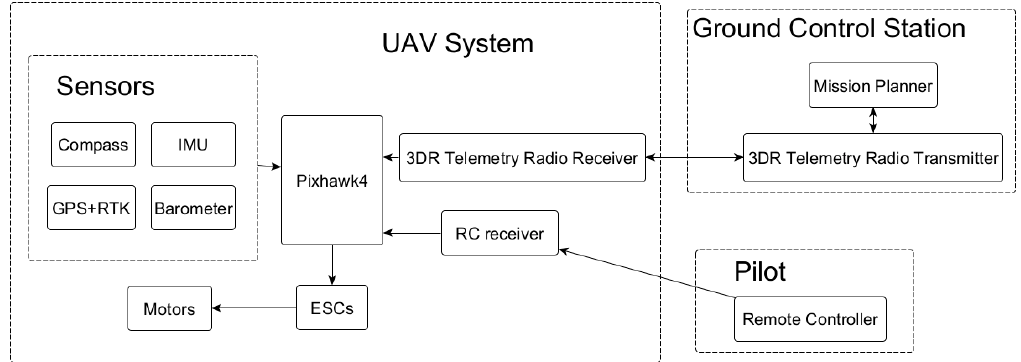
Figure 1. UAV system structure.